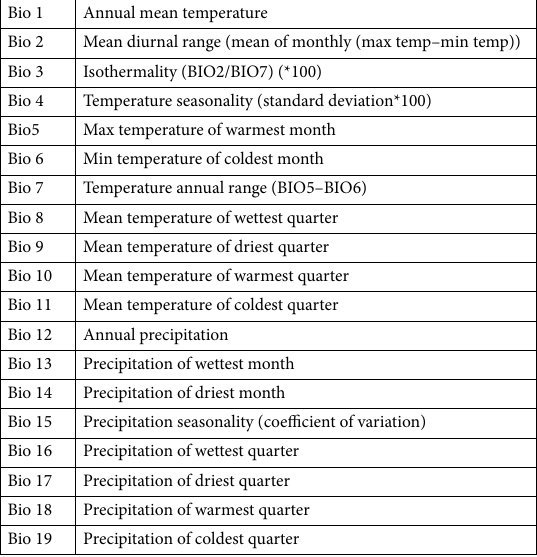
Table 2. Mean environmental variables (1970–2000).